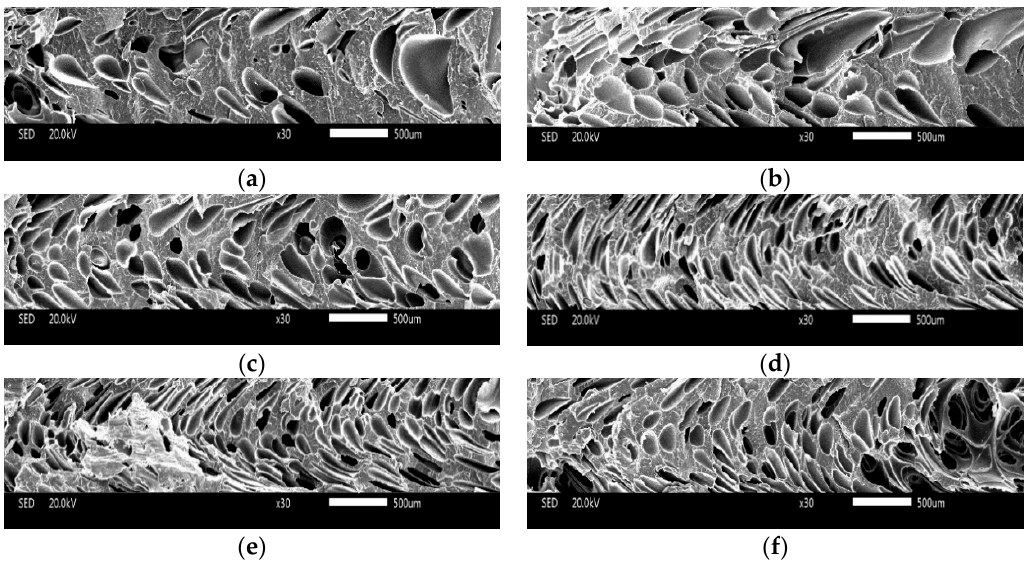
Figure 17. The cells structure of core layer of parallel sections with different content of nano ‐ CaCO 3 : ( a ) 0 wt%; ( b ) 2 wt%; ( c ) 4 wt%; ( d ) 6 wt%; ( e ) 8 wt%; ( f ) 10 wt%.